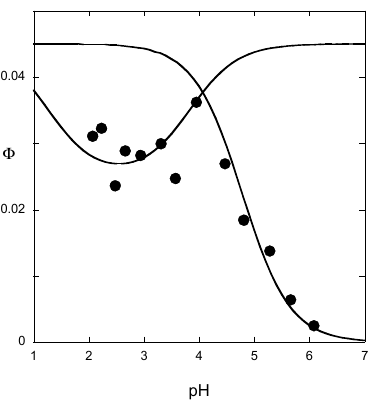
* Estimated error = 10%; all values obtained at room temperature.